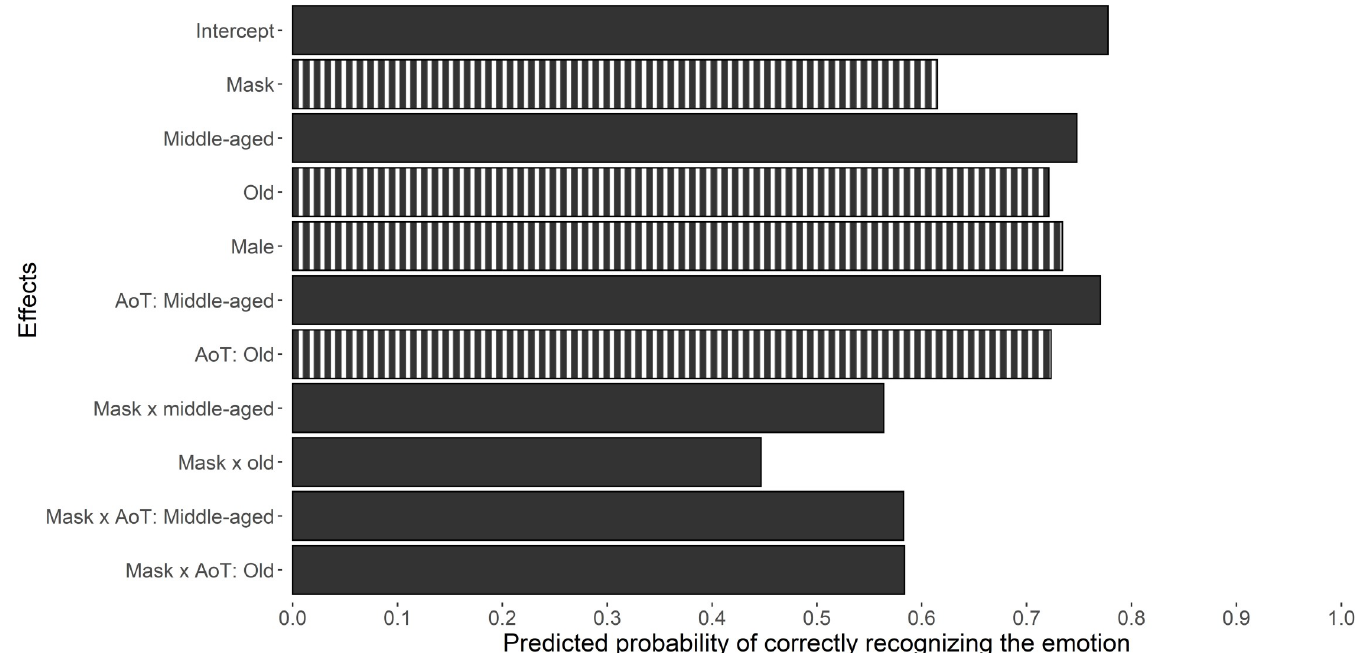
Fig 3. The effect of condition, age, gender, and age of target on emotion-recognition accuracy. The predicted effects are shown on the vertical axis, with the expected probability of accurate emotion recognition shown on the horizontal axis. The intercept represents the average expected probability of accurate emotion recognition for young females seeing young and unmasked faces. The ICC equaled .12. The striped pattern indicates a significant effect ( p < .05). AoT = age of target.